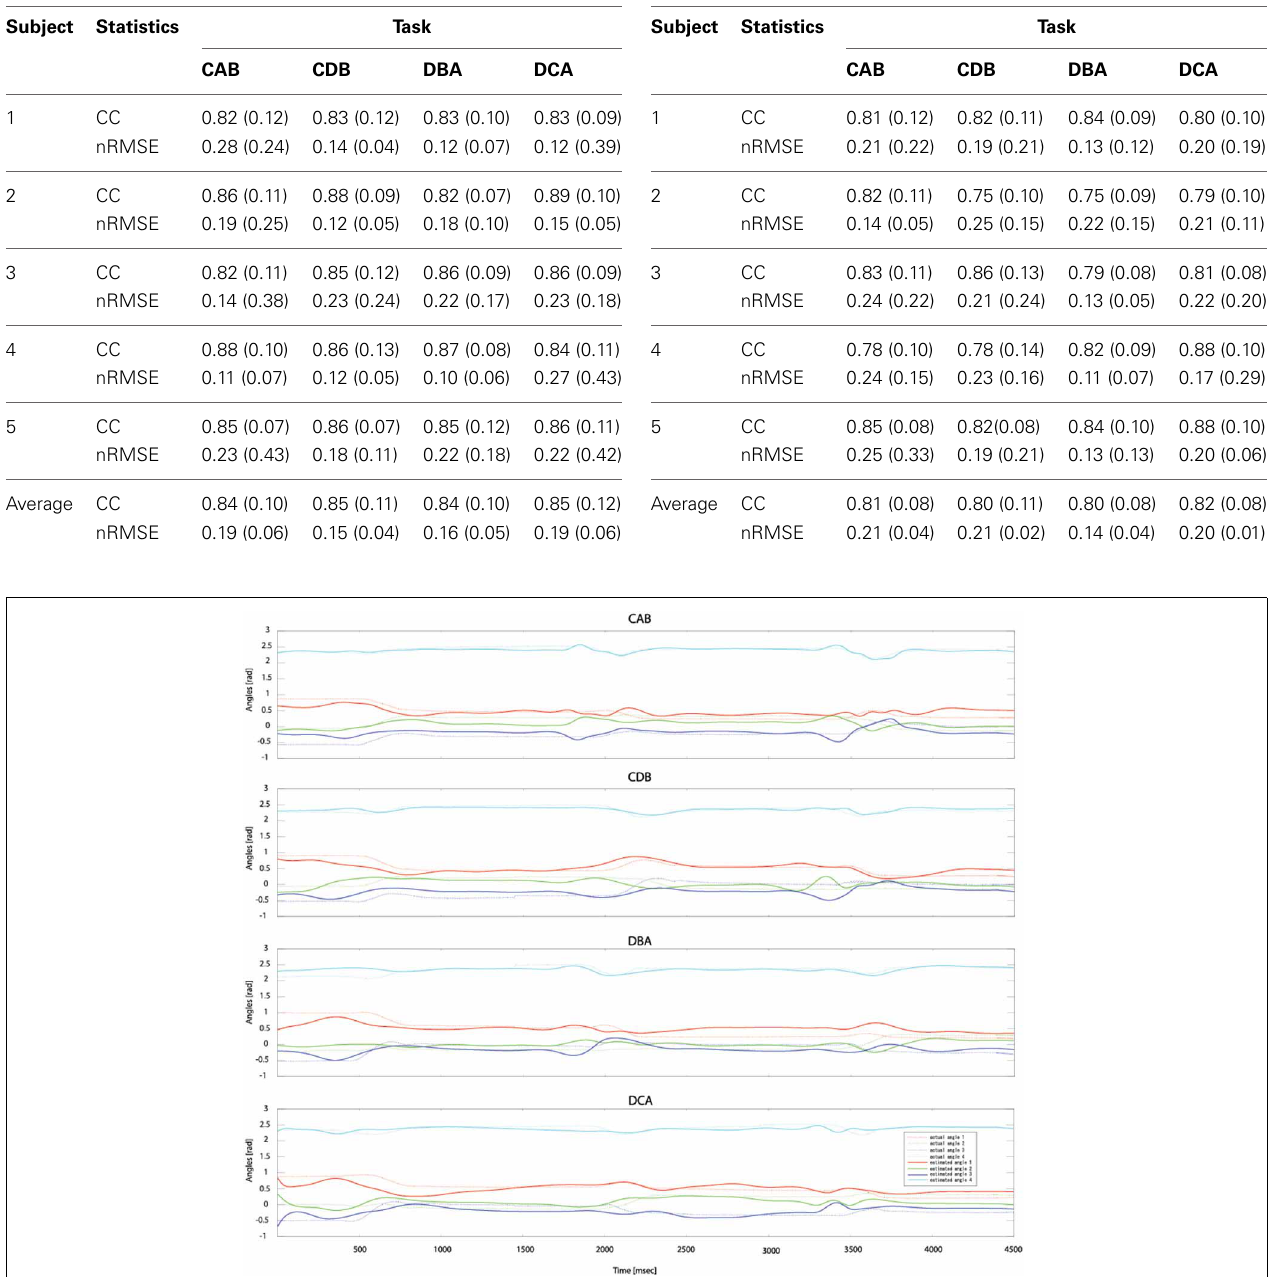
Frontiers in Neuroscience |